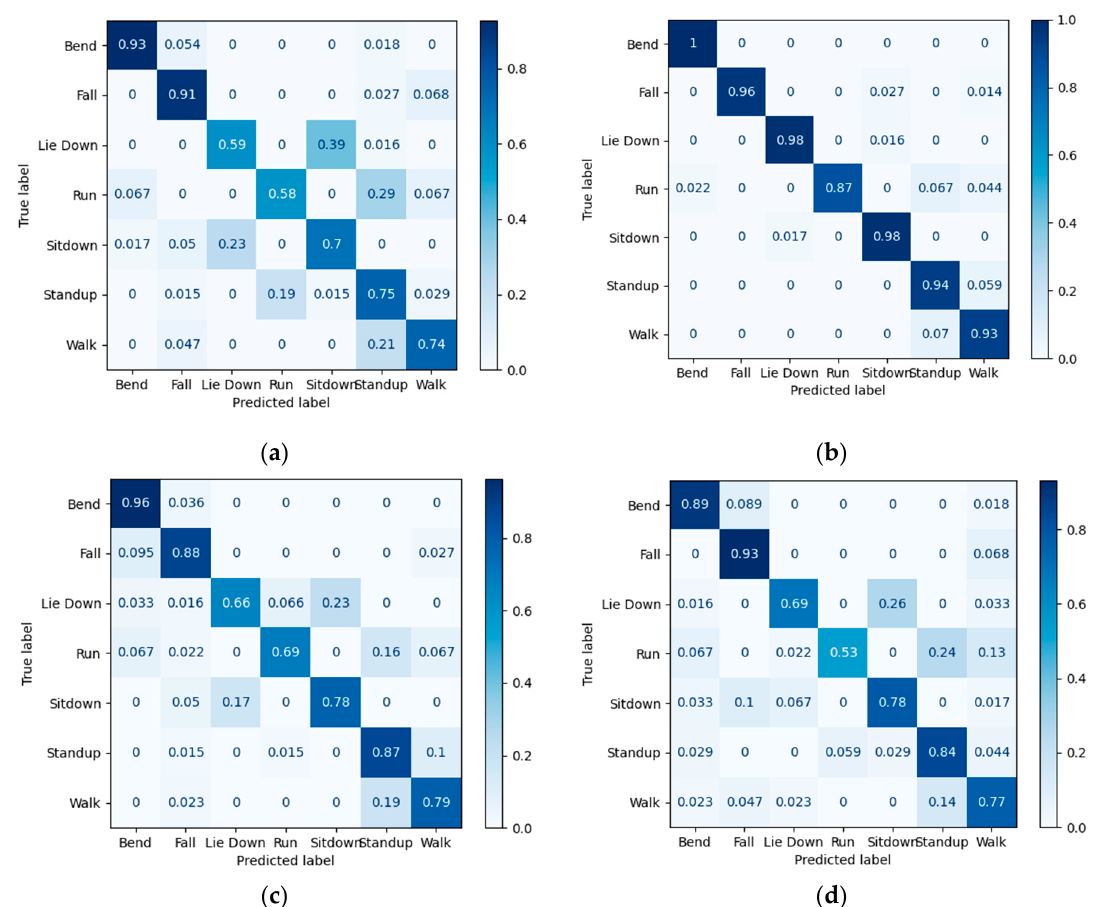
Figure 13. Confusion matrices of proposed methods, using 50% of the used data (including training and validation data): ( a ) designed classifier; ( b ) using retrainable encoder; ( c ) using untrainable encoder; ( d ) using the untrained encoder.